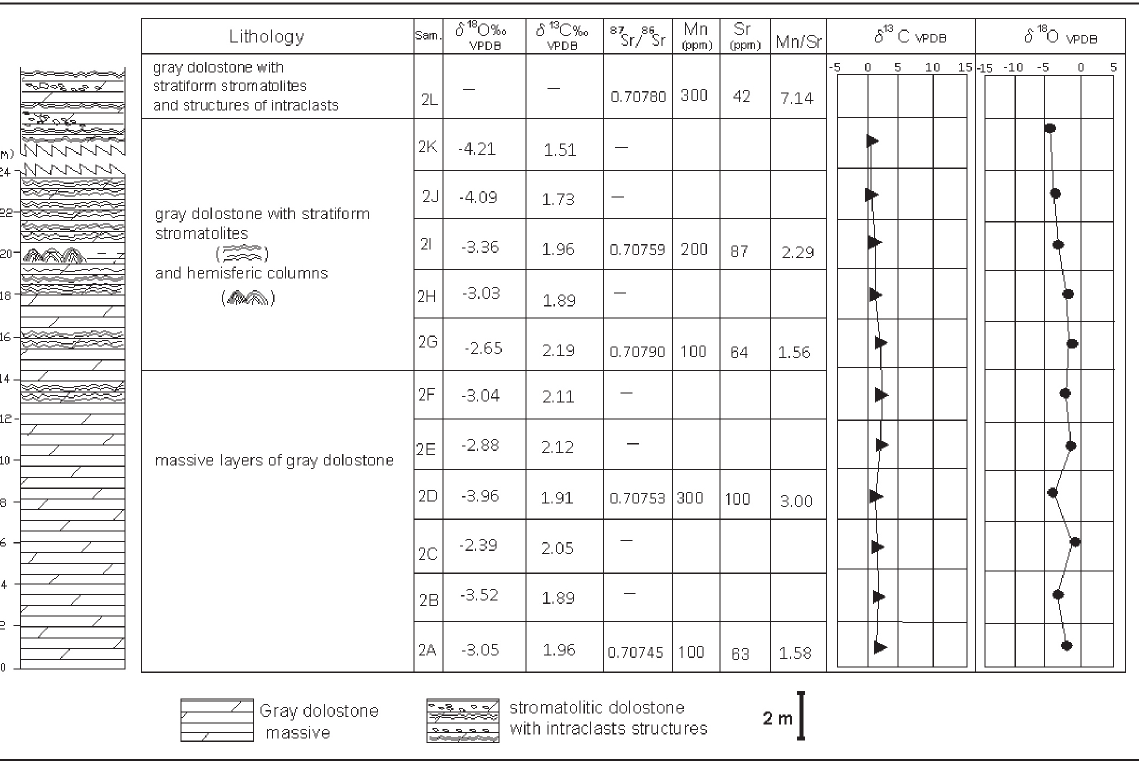
Figure 9 - Lithological variations, elemental and isotopic data of Section 3 – gray dolostone of Rio Pardo Grande Formation (for location, see Fig.